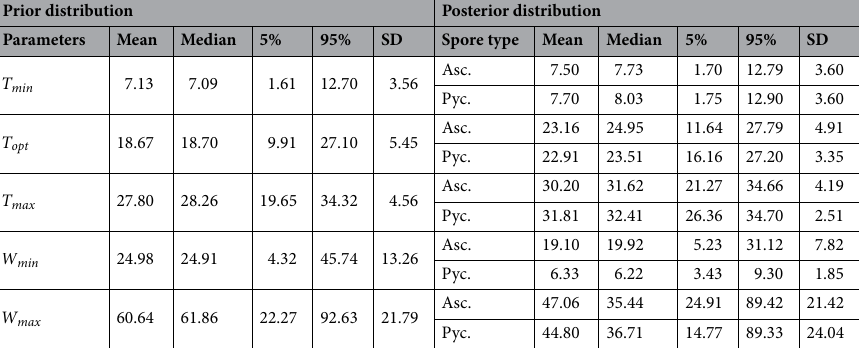
Table 1. Numerical descriptive (mean, median, 5% percentile, 95% percentile and standard deviation (SD)) for the prior and posterior distribution of the five model parameters ( T min , T opt and T max as the minimum, optimum and maximum temperature in ◦ C and W max and W min as the upper and lower bounds of the leaf wetness duration requirement W ( T ), in hours) for Phyllosticta citricarpa ascospores (Asc.) and pycndiospores (Pyc.) estimated by approximate Bayesian